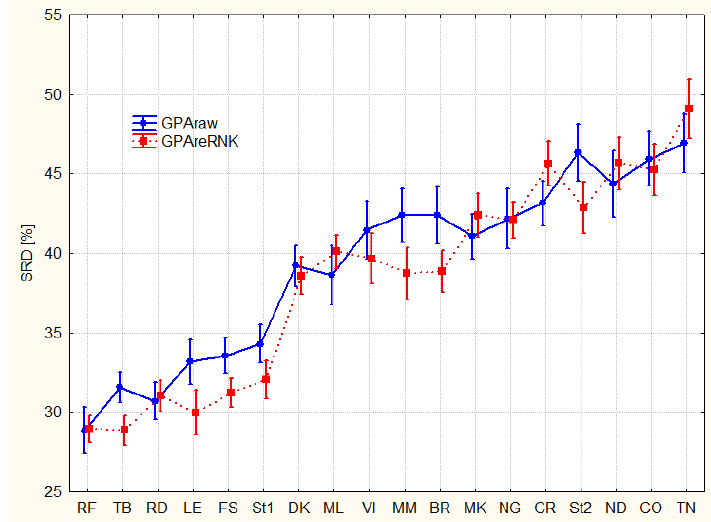
Figure 4. Splitting of experts according to ranking options (F2*F3); Sum of Ranking Differences, SRDs are scaled between 0 and 100. The error bars represent 95% confidence interval.